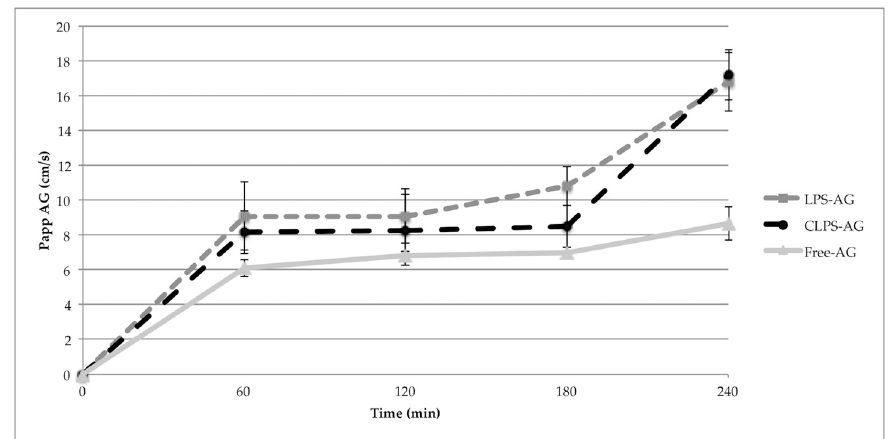
Figure 5. The apparent permeable coefficient of different liposomal formulations for different treatment time in the in vitro BBB model. (Data represent means ± S.D, n =